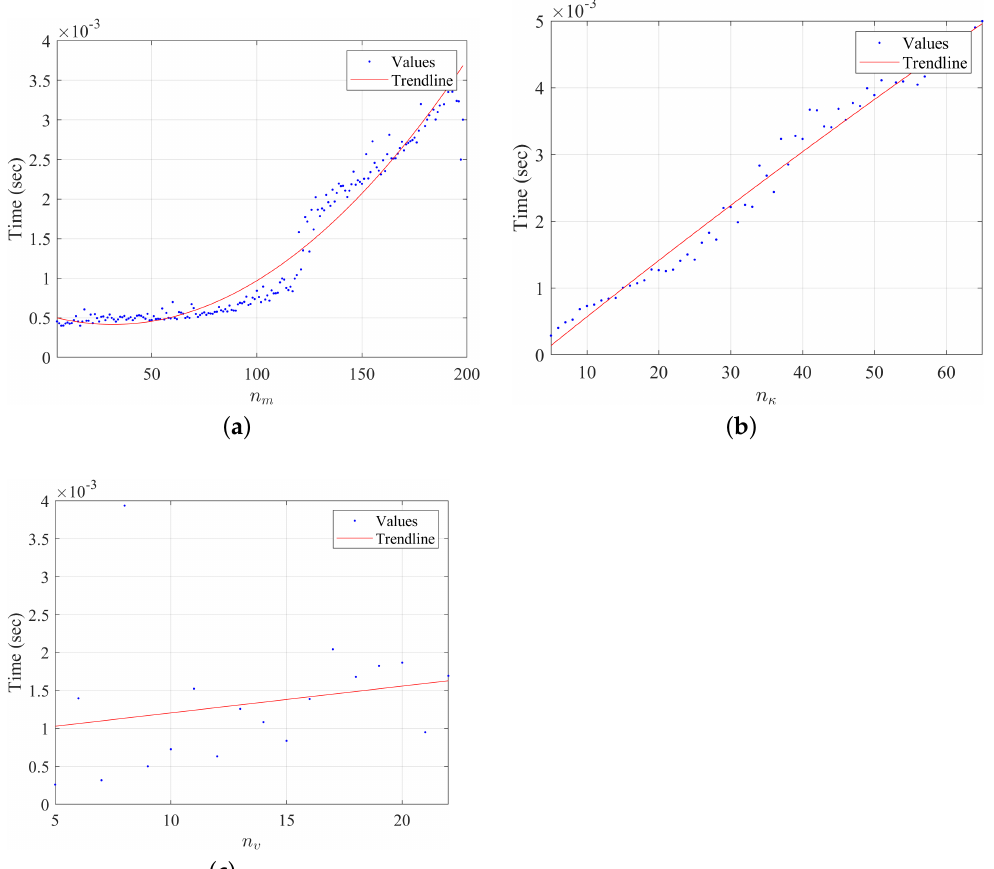
Figure 12. Computational time for different steps of EKF-SLAM with respect to the number of landmarks. ( a ) Computational time of prediction step vs. number of mapped landmarks, ( b ) computational time of update step vs. number of observed mapped landmarks, and ( c ) computa- tional time of registration step vs. number of observed unmapped